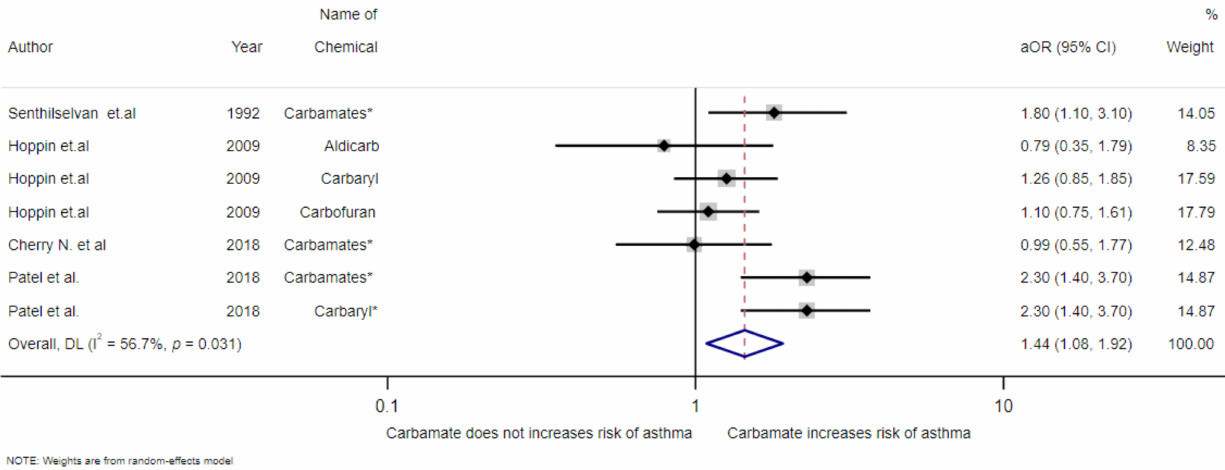
with an increased risk of asthmatic symptoms (OR = 1.44, 95%CI 1.08–1.92). Statistically